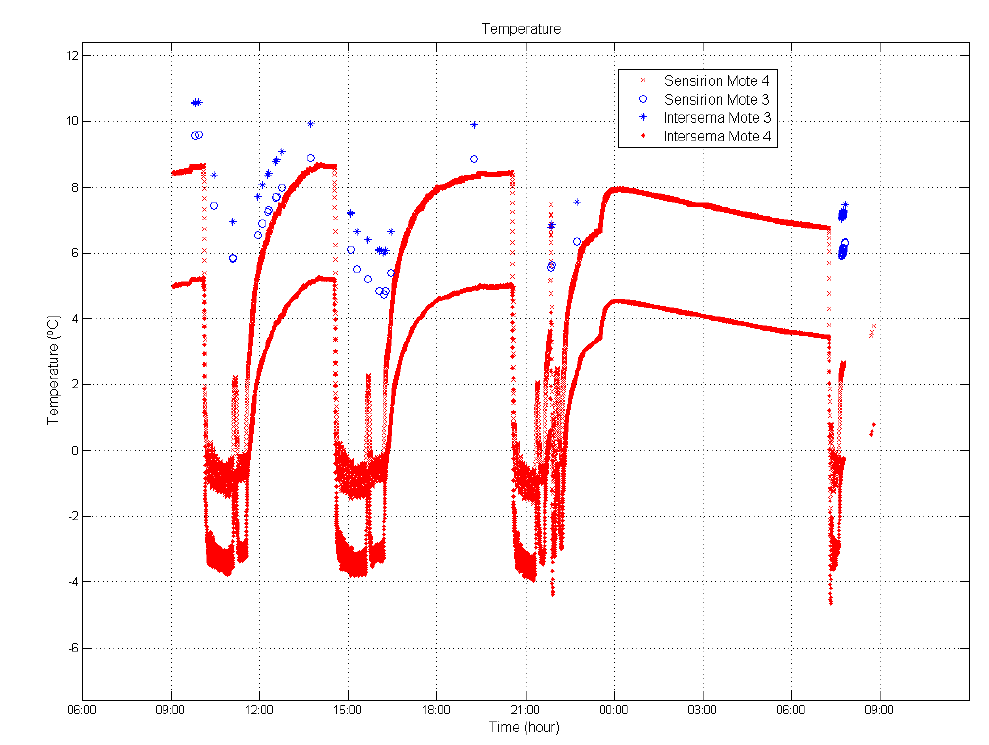
Figure 2. T comparison between motes and sensors.